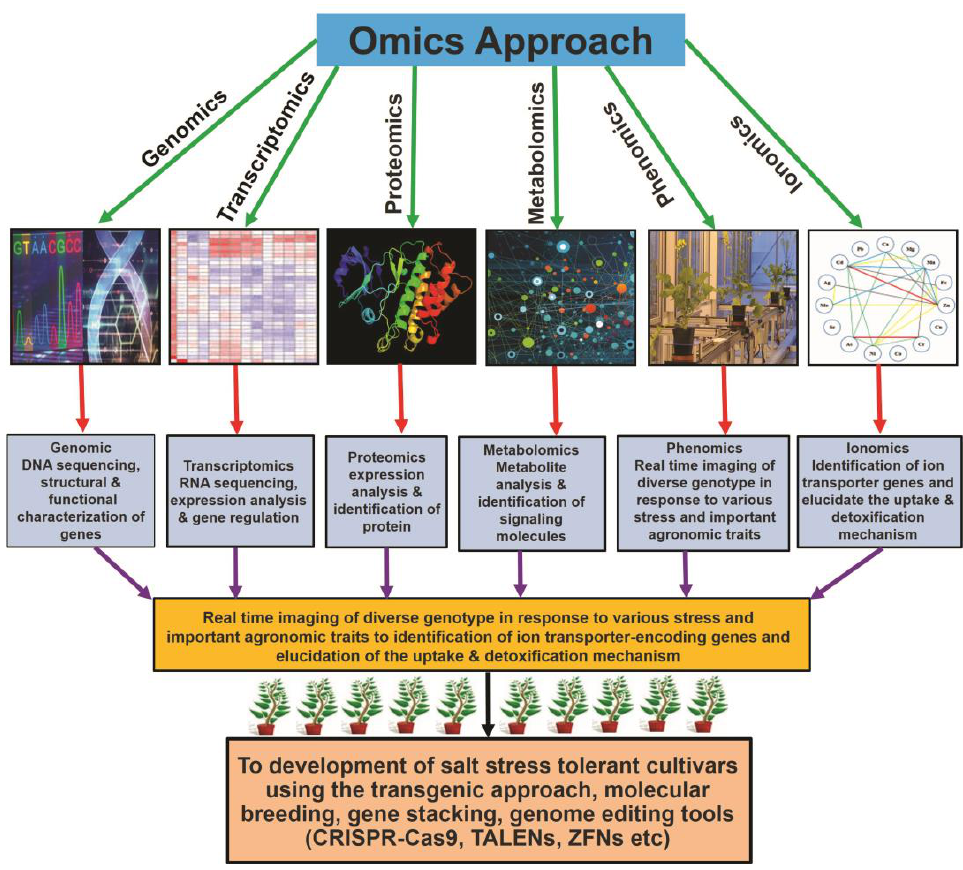
Figure 6. Utilization of different “-omics” approaches to develop salt-tolerant cultivars for improving the growth and productivity of different plant species.